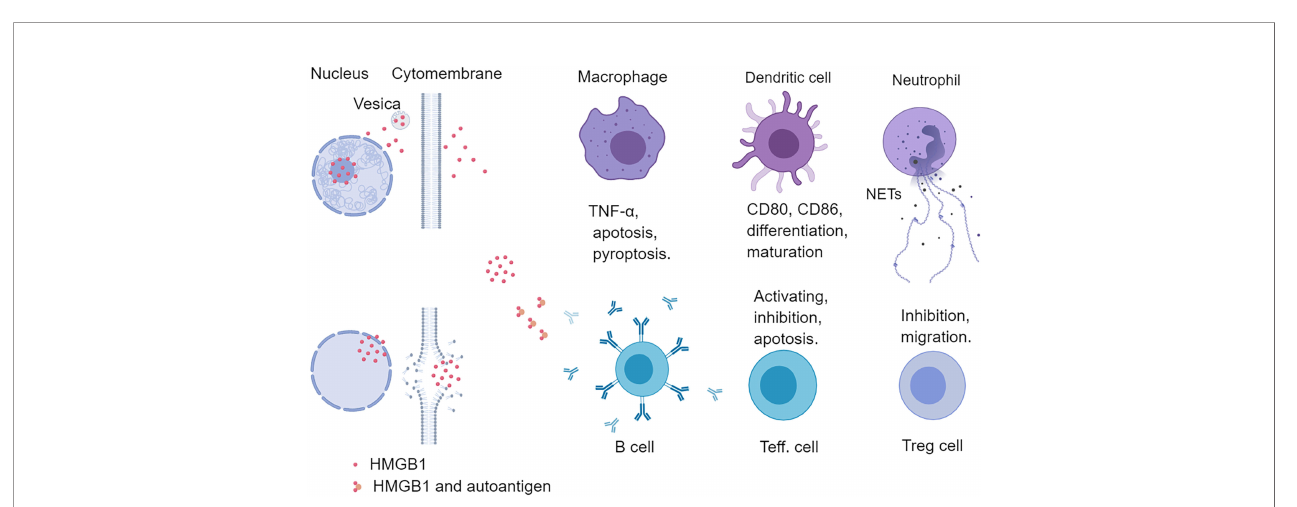
FIGURE 3 | Effects of HMGB1 on immune cells. HMGB1 can regulate both innate and adaptive immunity. HMGB1 can promote the release of pro-in fl ammatory factors from macrophages and induce apoptosis and pyroptosis of macrophages. HMGB1 can promote the differentiation and maturation of DCs and up-regulate the level of costimulatory molecules (CD80, CD86) of DCs. HMGB1 also promotes the neutrophil release of NETs, and HMGB1 is also abundant in NETs. HMGB1 can form a complex with a nucleic acid to promote the recognition of innate immune cells and T helper cells and stimulate B cells to secrete autoantibodies. Different concentrations of HMGB1 can exert different functions on effector T cells. Low concentration HMGB1 promotes the activation of T cells, while high concentration HMGB1 inhibits and even induces T cell apoptosis. HMGB1 can also directly act on Treg cells to promote their migration and survival. Teff., effector T cell; NETs, neutrophil extracellular traps.